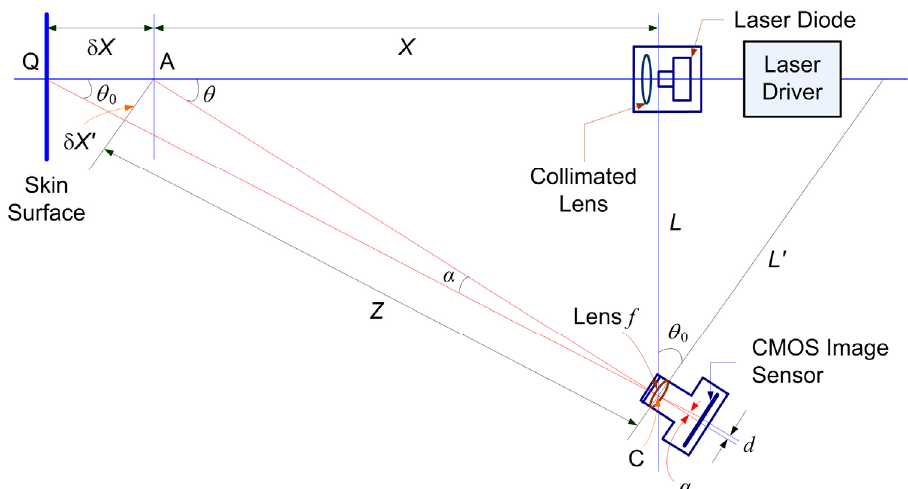
Figure 1. Geometrical layout of the arterial pulse measurement